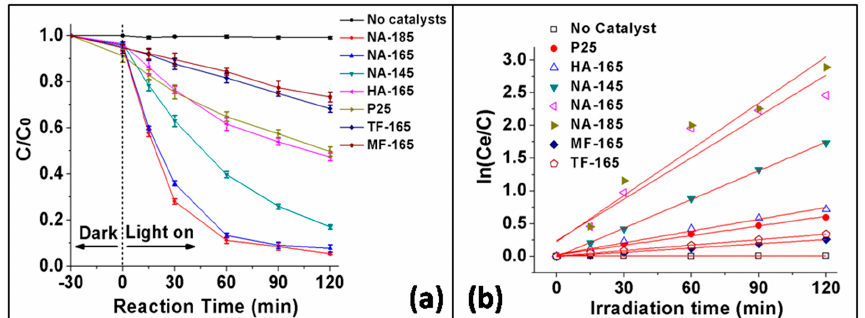
Figure 5. ( a ) Removal curves of methyl orange (MO). Error bars represent the standard deviation from three measurements; ( b ) Apparent first ‐ order kinetics plot for the photocatalytic degradation of MO over different samples.